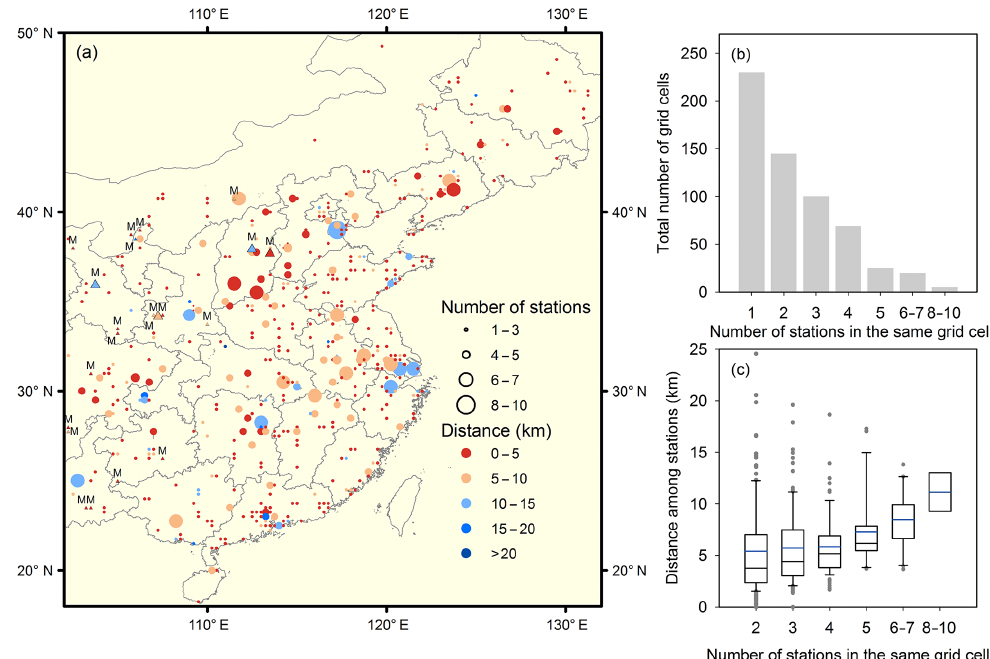
Figure 3. (a) Spatial distribution of in situ measurements. Measurements are allocated to the CHIMERE model grid cells based on their geolocations. The magnitude of the size of symbols denotes the number of stations located in the same grid cell. The color of the symbols denotes the average distance between stations located in the same grid cell. Triangles and “M” denote sites located in mountainous areas. (b) Histogram of the total number of grid cells with a certain number of stations. (c) Statistics of the averaged distance among stations located in the same grid cell. The black and blue horizontal lines are the median and mean of the averaged distance, respectively; the box denotes the 25 and 75% percentiles, and the whiskers denote the 10 and 90% percentiles. The grey dots denote the outliers.